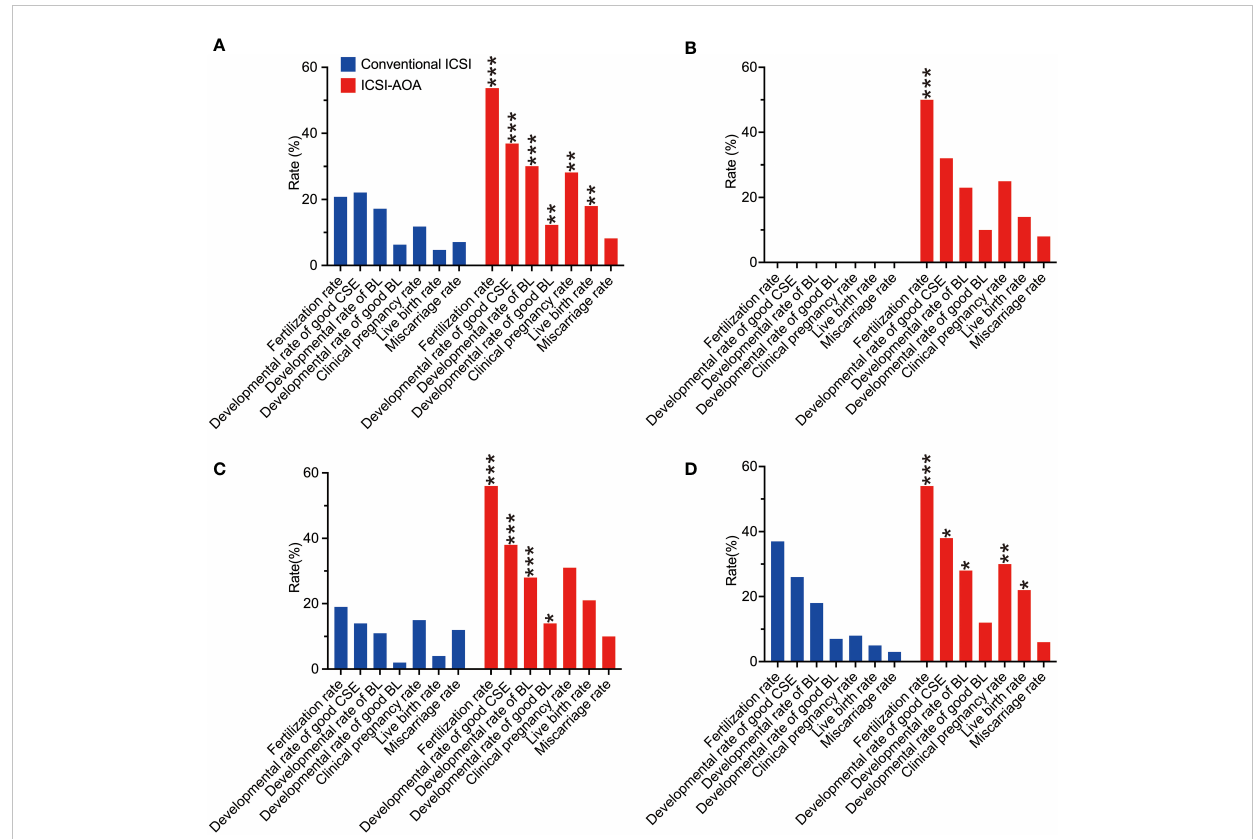
FIGURE 2 Embryological and clinical outcomes of intracytoplasmic sperm injection (ICSI) and subsequent arti fi cial oocyte activation (AOA) treatment. The patients were distributed into different groups based on their fertilization rates from an initial ICSI cycle. The different categories were: (A) all couples (n=198), (B) total failed fertilization (0%, n=84), (C) low fertilization (>0% to <30%, n=64), and (D) moderate fertilization (30% to <50%, n=50). In the total failed fertilization group, p-values could not be calculated for the comparison of developmental outcomes with the ICSI-AOA group because fertilized eggs were not obtained in the 0% fertilization rate group. CSE, cleavage stage embryo; BL, blastocyst stage embryo. * p <0.05, ** p <0.01, *** p